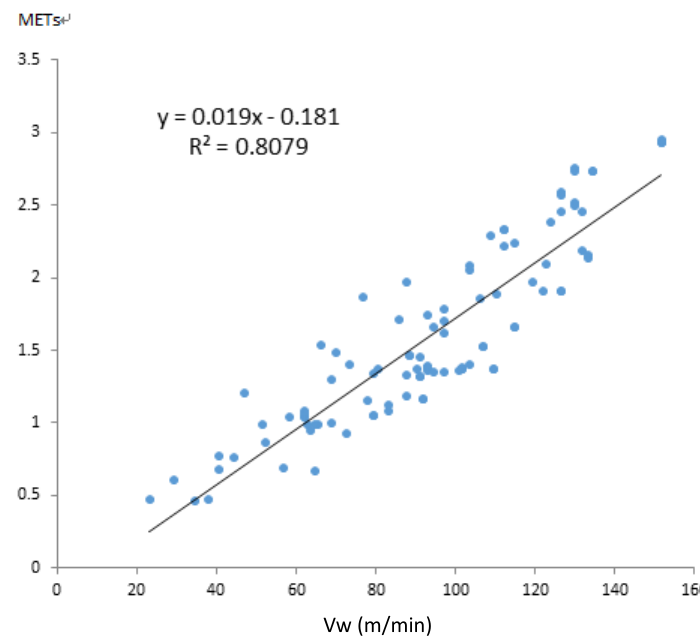
Figure 17. Results of the improved velocity calculation algorithm developed in this